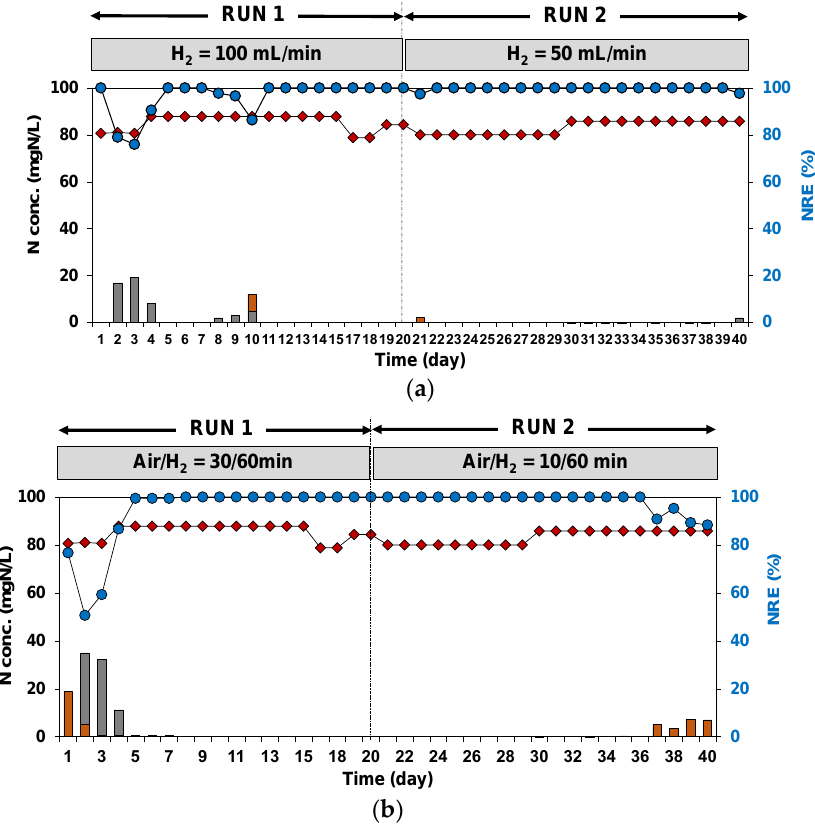
Figure 3. Effluent NO 3 –N and NO 2 –N concentrations and nitrogen removal efficiency (NRE) in ( a ) reactor A and ( b ) reactor B.